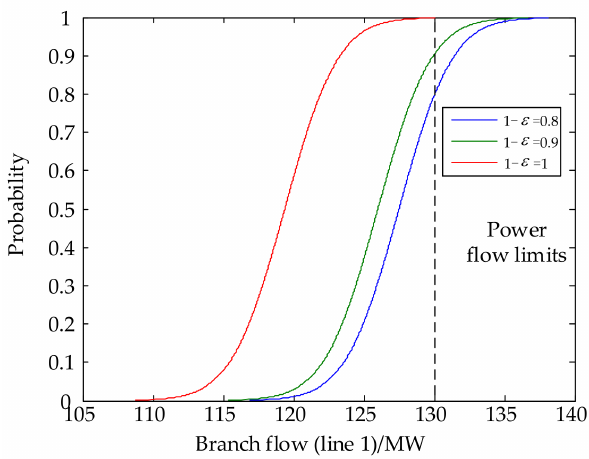
Figure 7. Line flow distribution under different confidence